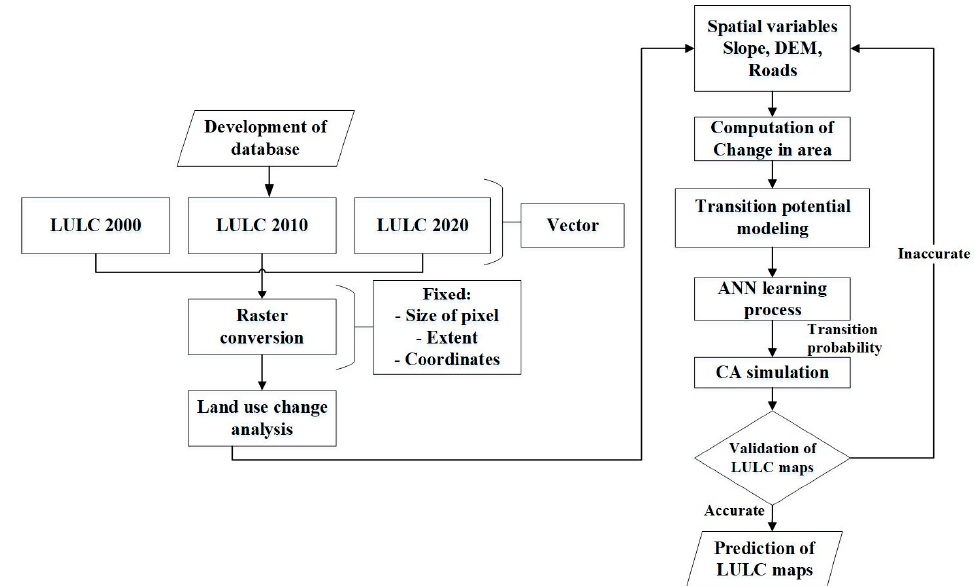
Figure 5. Flow chart of future LULC prediction mapping.